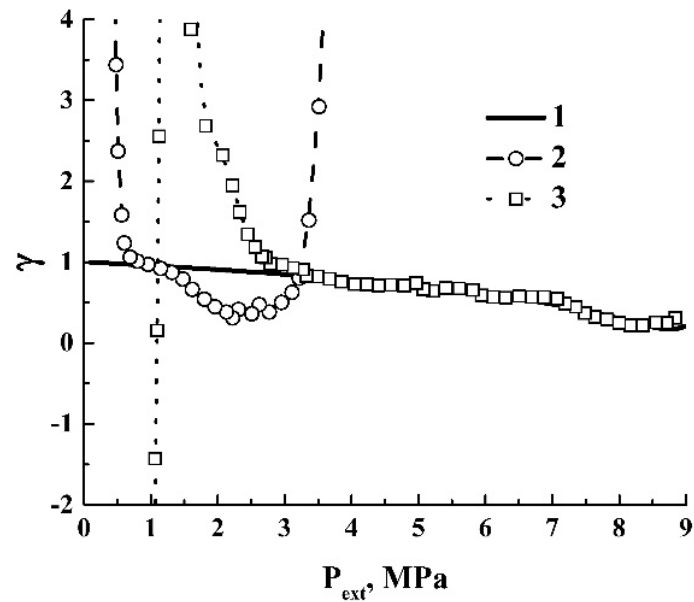
Figure 13. Theoretical isothermal dependence γ ( P ) for carbon dioxide (1) and empirical values γ ( P ext ) for the polylactide foam (2, 3).